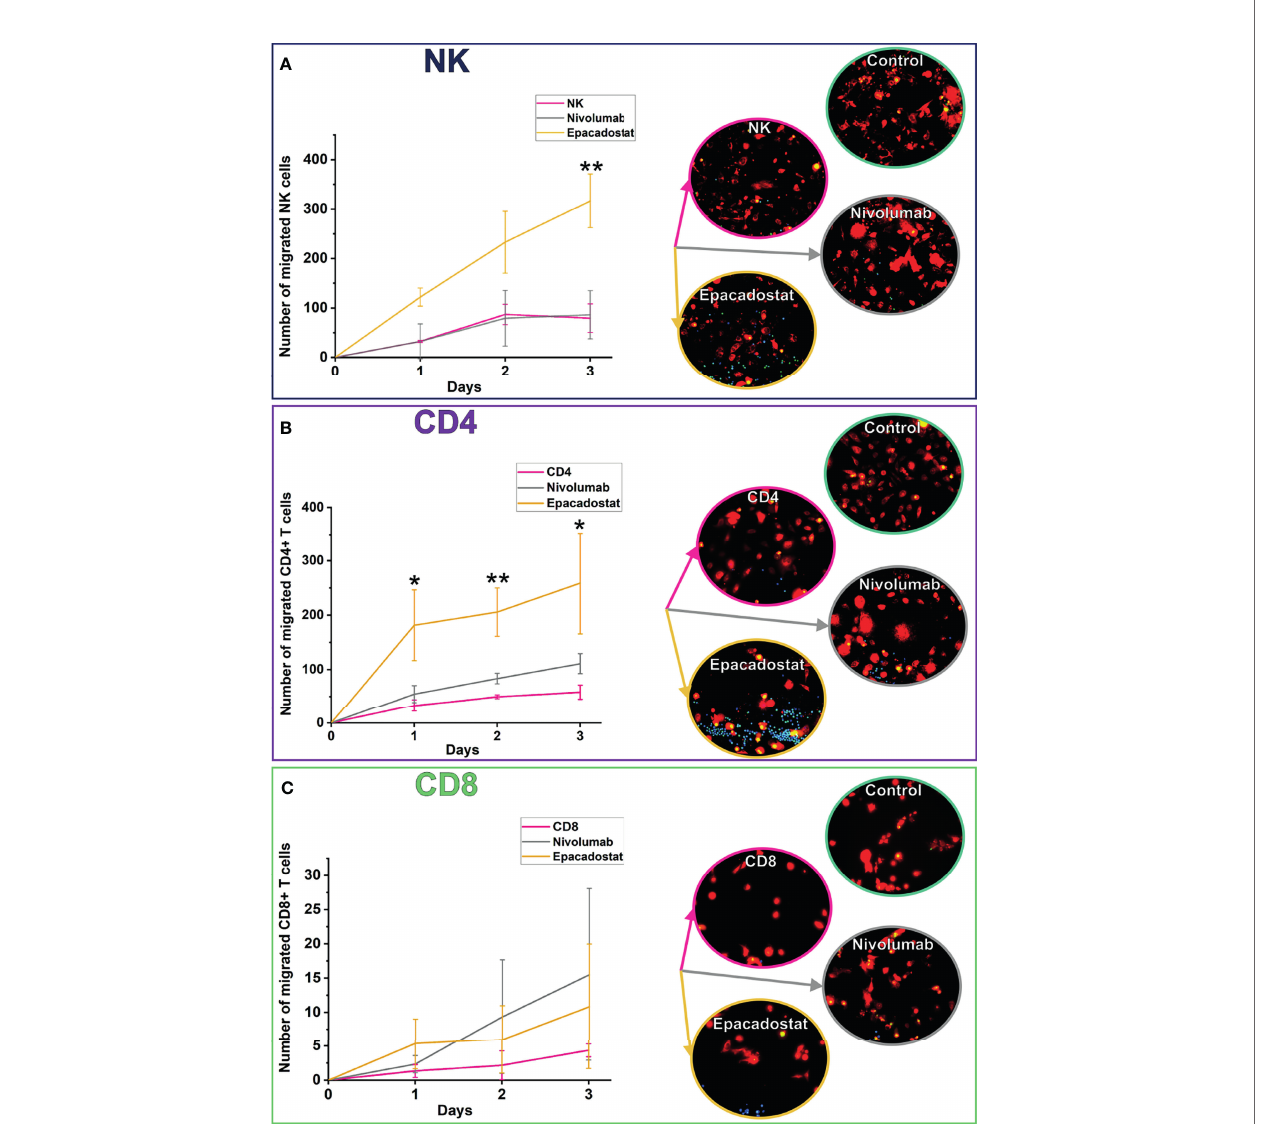
FIGURE 2 | Migration of NK, CD4 + , and CD8 + T cells towards cancer cells over 3 days. NK cells migrated signi fi cantly more with epacadostat incubation than in the NK control on day 3 ( A ; **p=0.009). The effect was observed also with CD4 + T cells but on all the 3 days of the experiment ( B ; day 1 *p=0.027, day 2 **p=0.003, day 3 *p=0.033). CD8 + T cells did not signi fi cantly differ in migration (C) . HSC-3 cells are shown in red, lymphocytes in blue, and apoptotic cells in green in the fl uorescence images. Results are reported as the average number of lymphocytes migrated ± SD. The experiments were repeated three times, each time using a different donor and each in duplicate. NK, natural killer cell; CD4, CD4 + T cells; CD8, CD8 + T cells